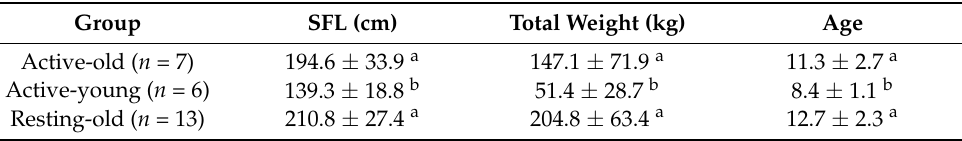
Figure 2. Principal Component Analysis showing the three groups (Active-old, Active-young, Resting-old) identified in the present study. The two subgroups Active-old and Active-young correspond to individuals of the reproductive period and the group Resting-old to individuals of the non-reproductive period. The proportion of explained variance along the axes is reported in brackets. Table 1. Biometric data of bluefin tuna specimens for each group. Data are shown as mean ± standard deviation. For each variable, different letters correspond to statistically significant differences ( p < 0.05). SFL: Straight Fork Length.